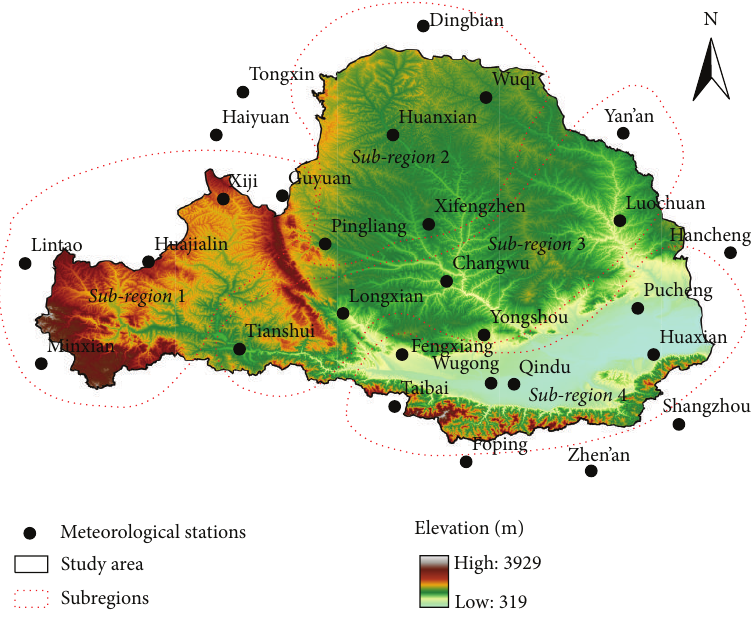
Figure 5: The division of four subregions of the WRB using the K -means method in the hierarchical cluster analysis. Table 2: The statistical characteristics of AMDSL in each subregion of WRB.